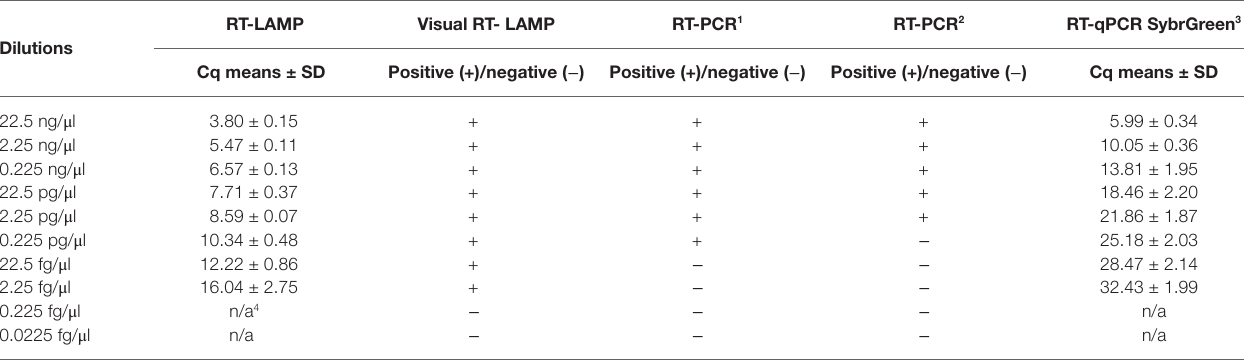
TABLE 3 | Sensitivity of LAMP used for the ToBRFV detection with different techniques. Dilutions